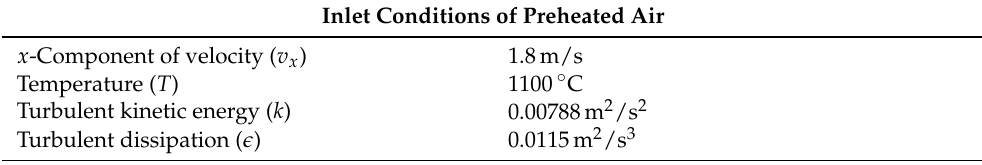
Table 2. Inlet conditions for preheated air and natural gas in single section of anode baking furnace. Inlet Conditions of Preheated